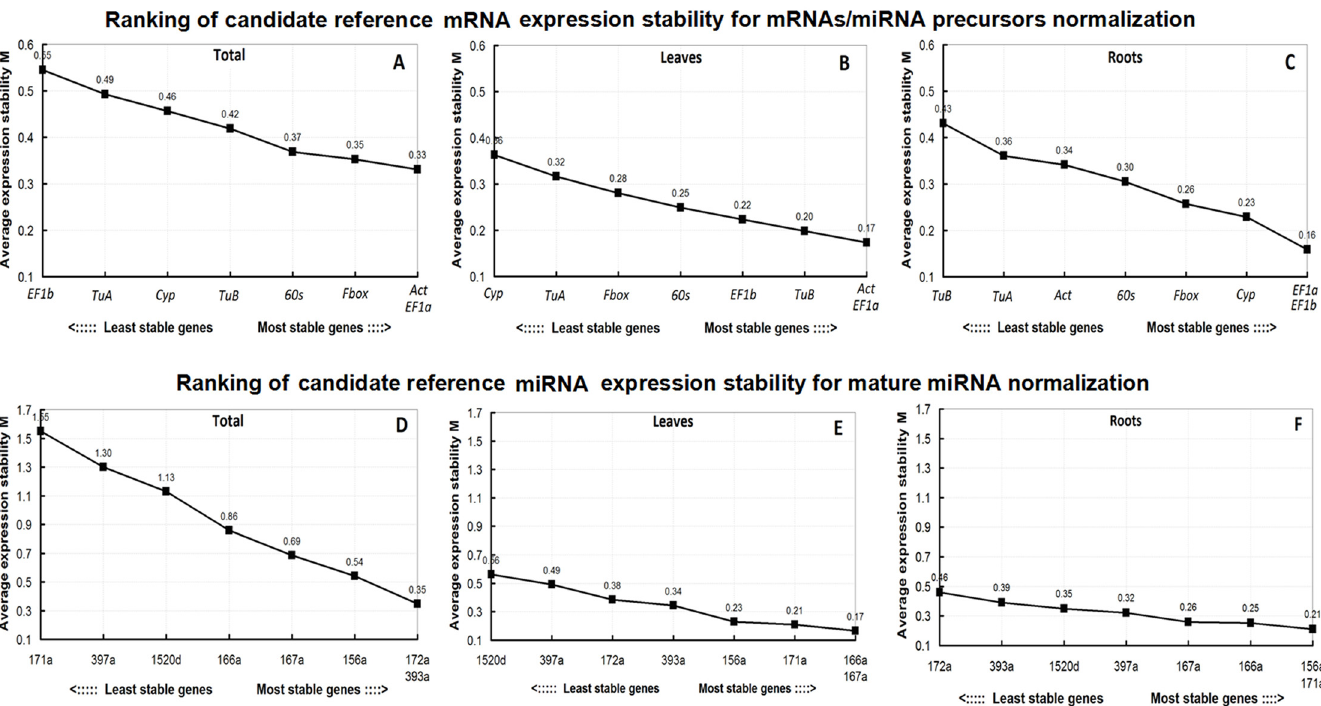
Fig 2. Ranking of the candidate reference mRNAs and candidate reference miRNAs by geNorm. The ranking of candidate reference mRNA/ miRNAs was based on average expression stability values (M). A lower M value indicates a more stable expression level. The six tested groups are the same as those indicated in Fig 1 (Group A to